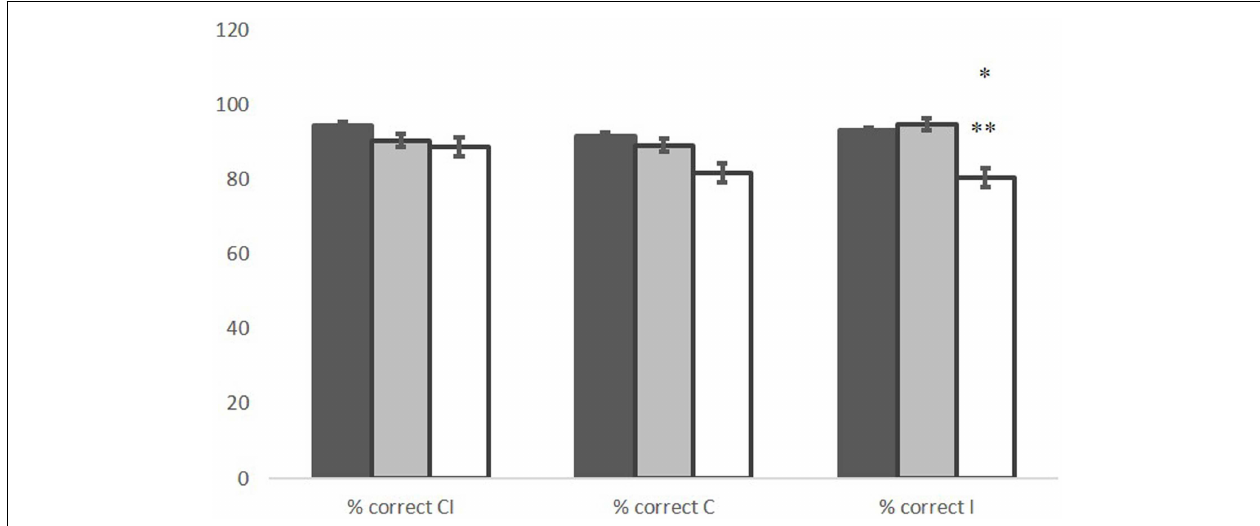
FIGURE 1 | Percentage of correct responses in the choice and the go/no-go condition, in control (black), PLS (gray), andALS (white) groups . *ALS vs. CNT p = 0.014; **ALS vs. PLS p = 0.05. Line bars over each column indicate Standard